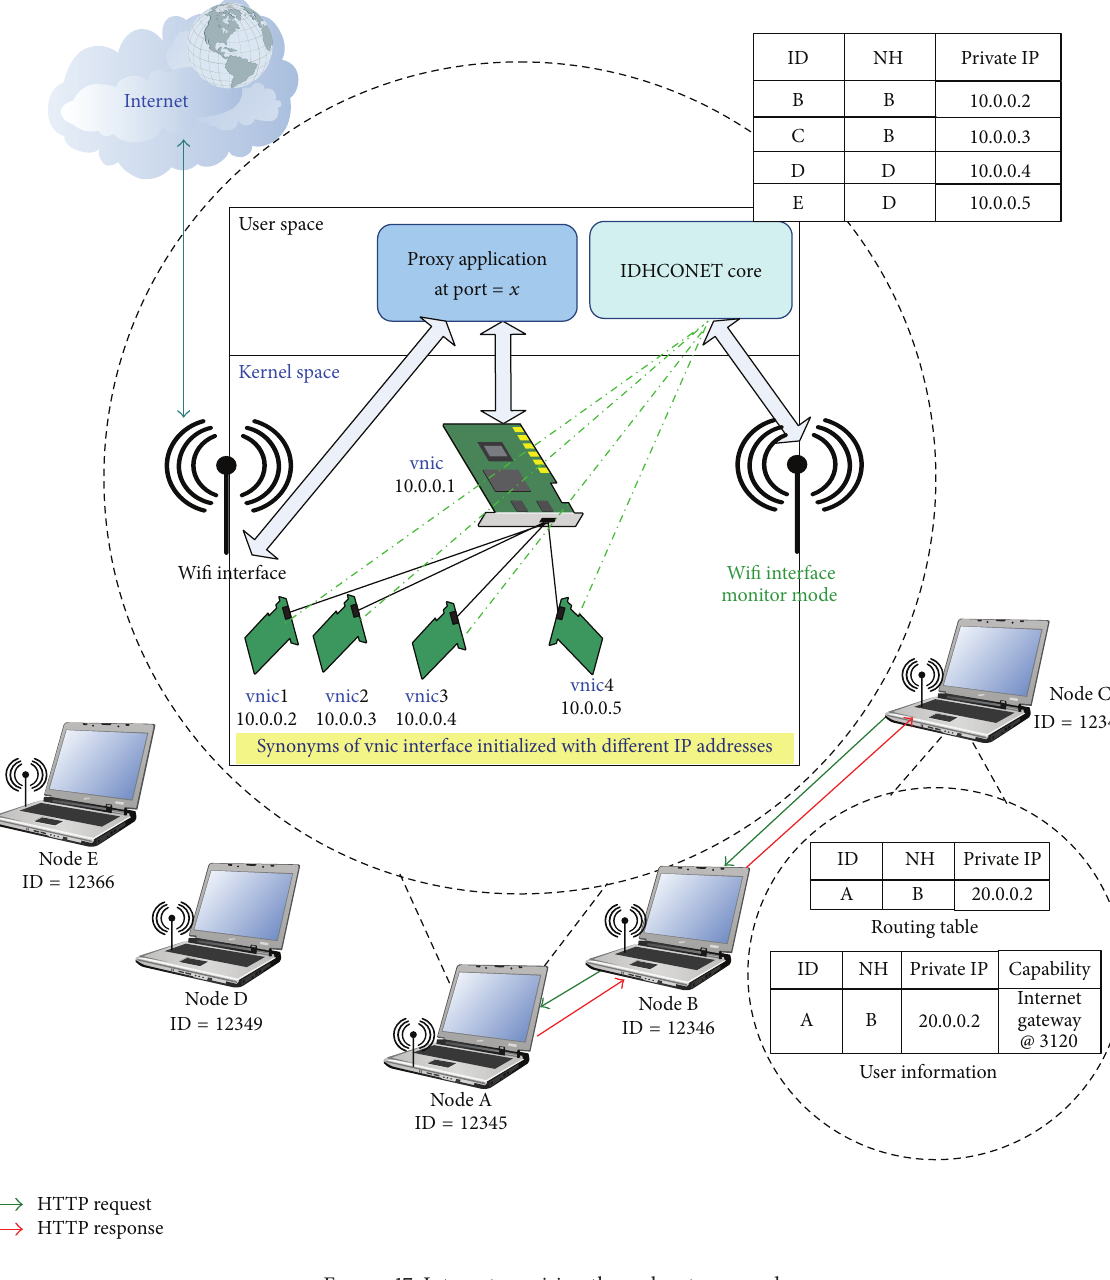
Figure 17: Internet provision through gateway